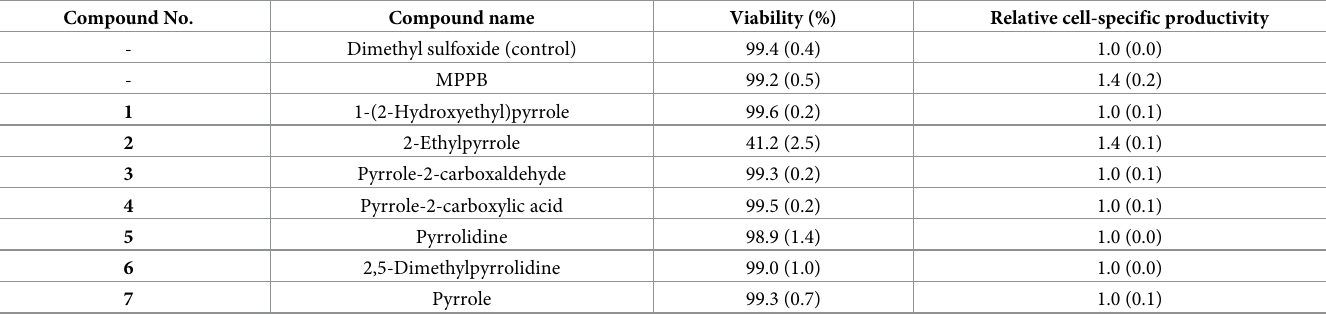
Table 1. Effect of pyrrole derivatives on viability and relative cell-specific productivity in rCHO cell cultures. Compound